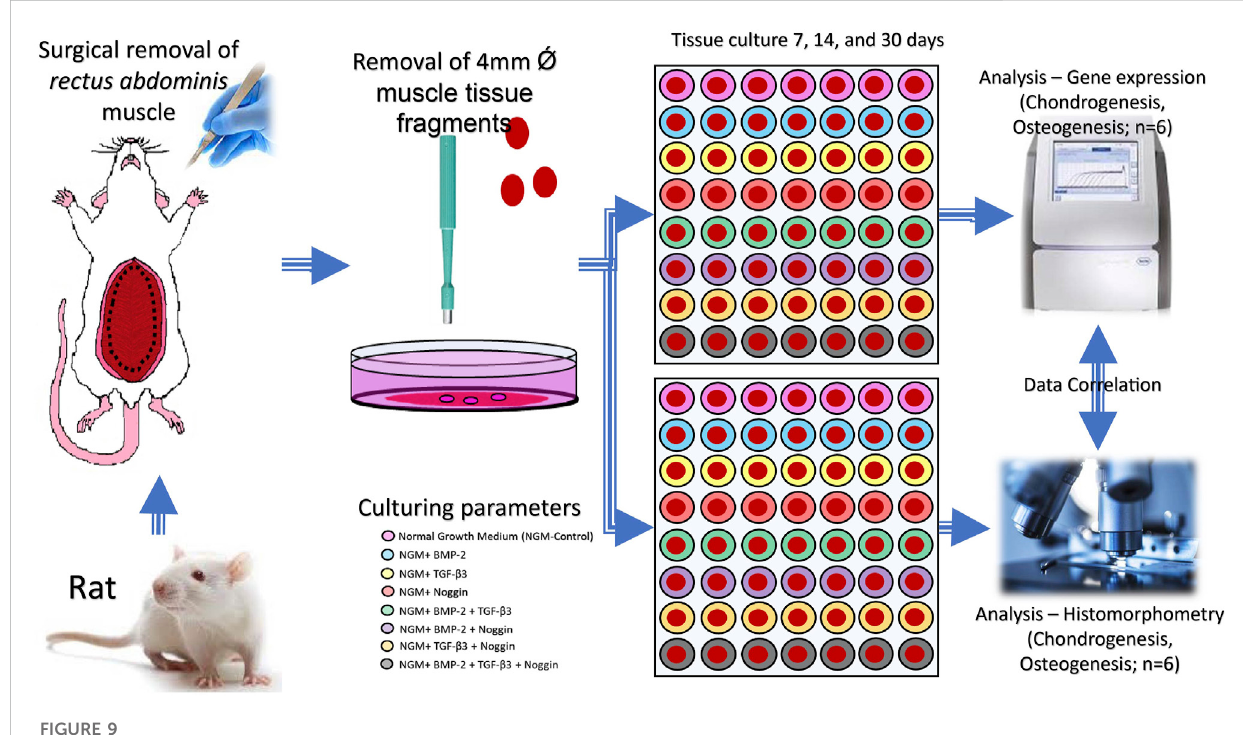
FIGURE 9 A graphical abstract of the whole